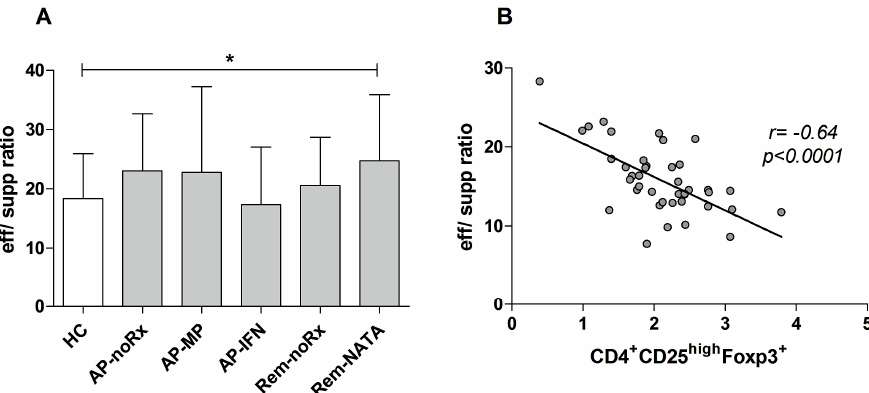
Figure 6. ( A ) Effector/suppressor ratios of HC and patient groups after cultures of PBMC in the absence of antigenic peptides. Note the complementarity with the CD4 + CD25 high Foxp3 + frequencies in Figure 1. * p = 0.05; and ( B ) correlation of effector/suppressor ratios in culture, with the percentage of corresponding CD4 + CD25 high Foxp3 + Tregs (Spearman r = − 0.64, p < 0.0001).